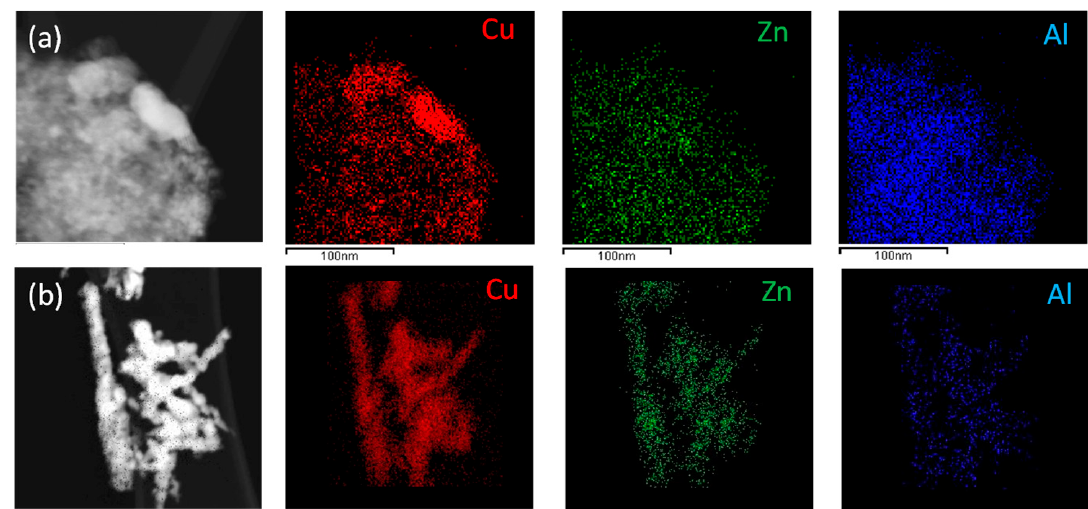
Figure 4. EDX compositional maps of Cu, Zn, and Al in CZA_30 ( a ) and CZA_60 ( b ).